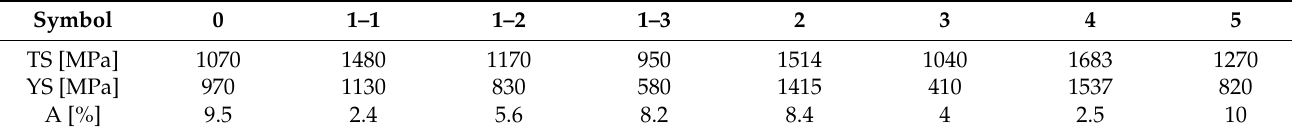
Table 3. Mechanical properties of the analyzed alloys.